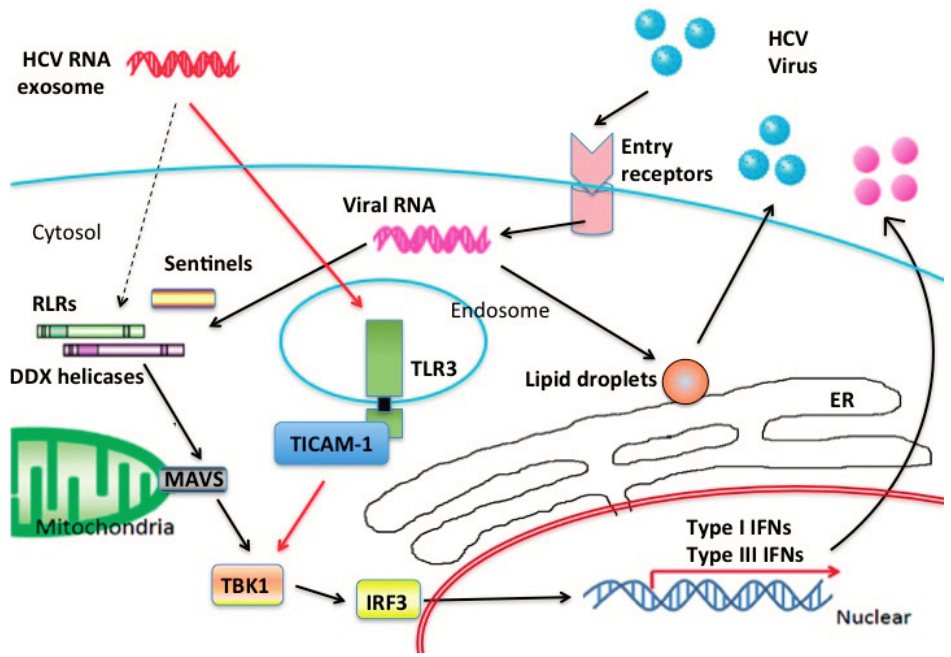
Figure 1. Nucleic acid sensors in HCV infection. Possible innate RNA-sensors participating in the recognition of HCV RNA are illustrated in this figure. In hepatocyte cytoplasm, major RNA sensors are RLR family proteins although many sentinels help RLRs to recognize viral RNA. On the other hand, in stromal cells TLR3 can work as a main sensor for HCV RNA released from the foci of HCV infection. Type III IFNs are the main product of the TLR3 signal in response to exogenous dsRNA. CD8+ DC rapidly secrete IFN-lambda in acute phase HCV